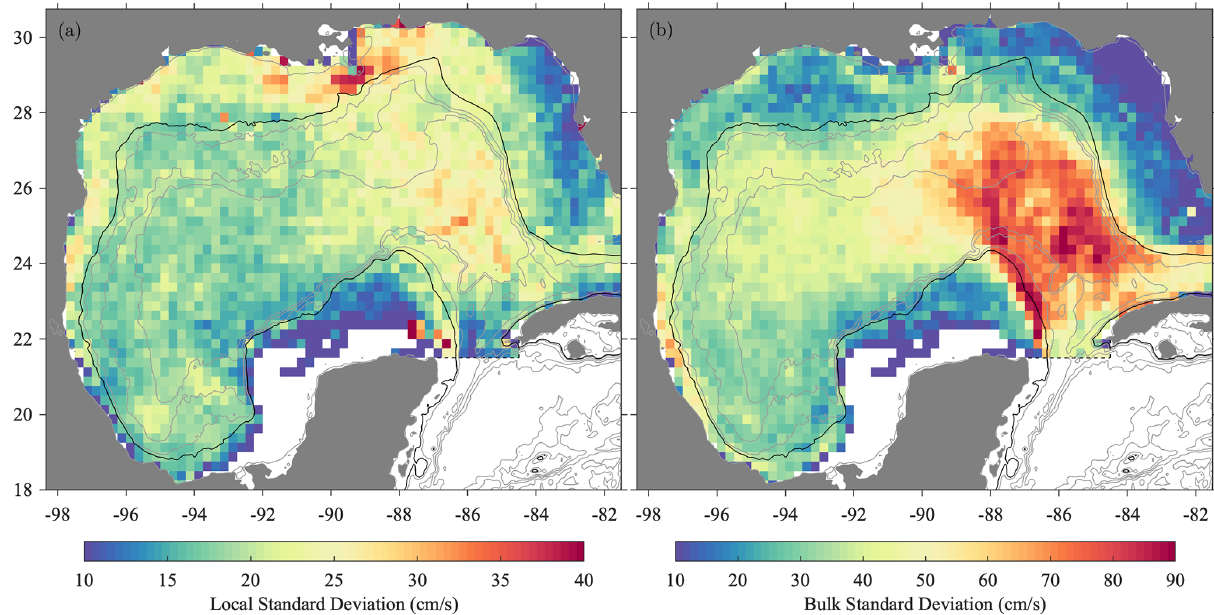
Figure 7. The square roots of (a) the local variance (cid:15) 2 and (b) the bulk variance σ 2 , as defined in the text. Note the different color bar